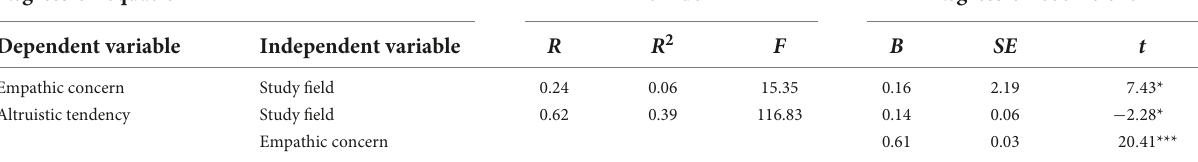
TABLE 3 Analysis of empathic concern as a mediator.